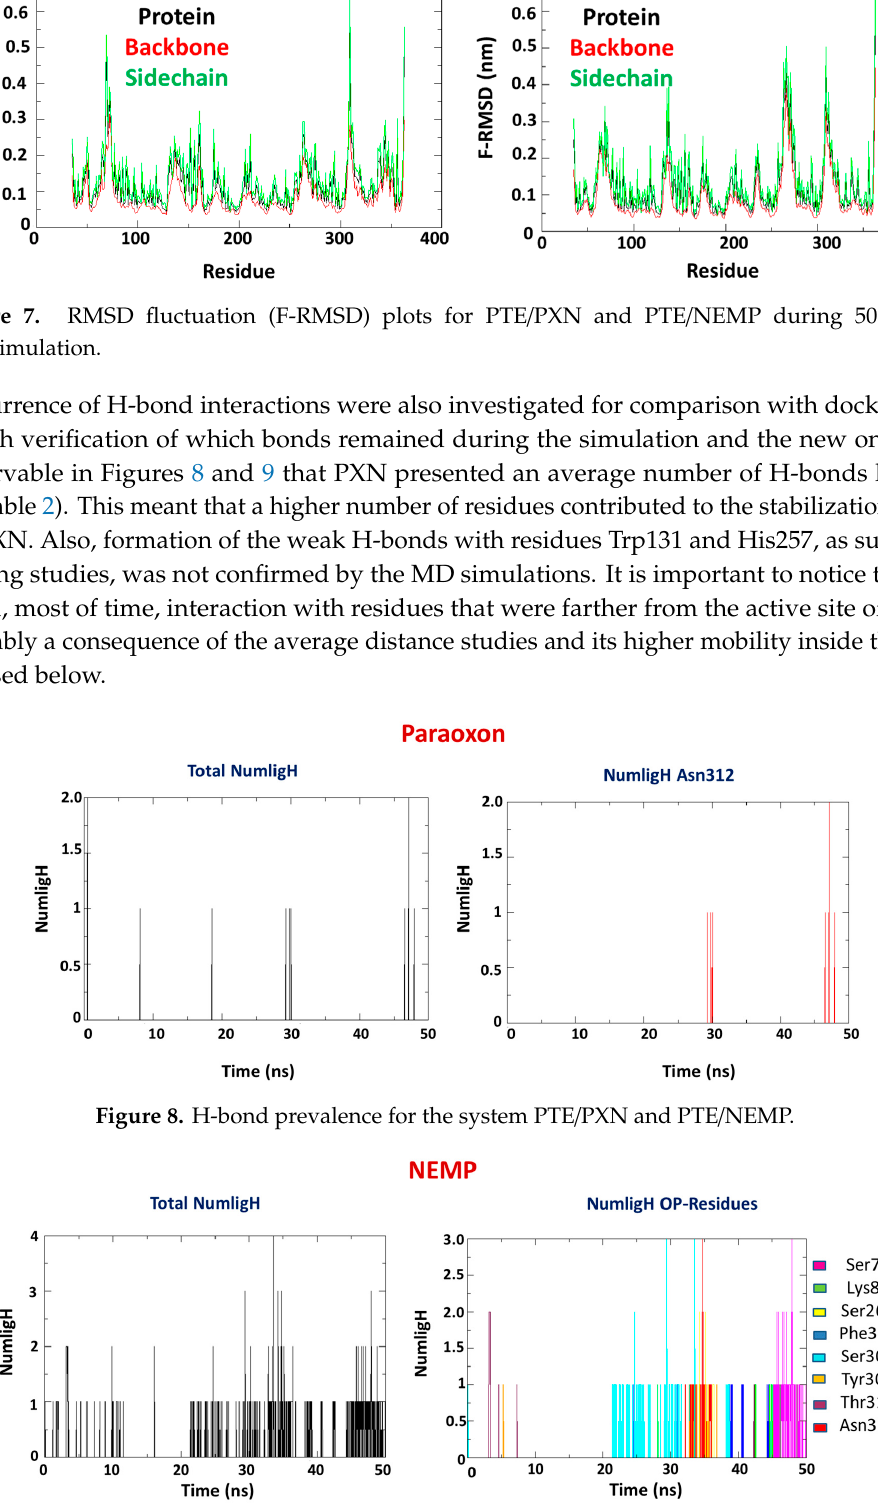
Figure 9. H-bond prevalence for the system PTE/NEMP.